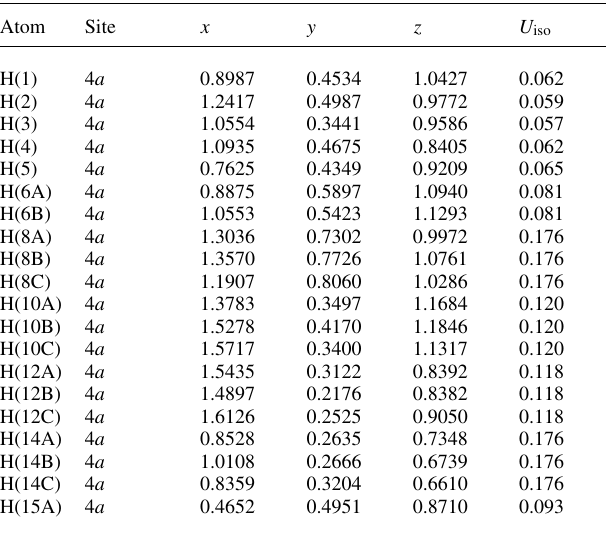
Table 2. Atomic coordinates and displacement parameters (in Å 2 )